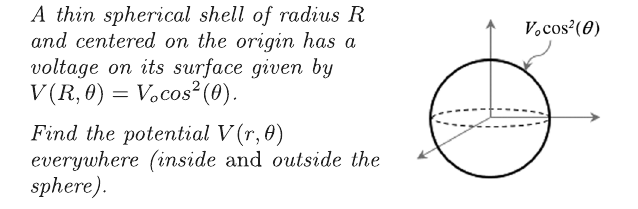
FIG. 2. An example of a canonical exam problem targeting spherical SOV. Variations on this question include providing a simpler or more complex expression for the boundary [e.g., V ð R; θ Þ ¼ V cos θ ], giving the boundary condition in terms of o Legendre polynomials [e.g., V ð R; θ Þ ¼ P 9 ð cos θ Þ ], or only ask- ing for the potential inside or outside the sphere.